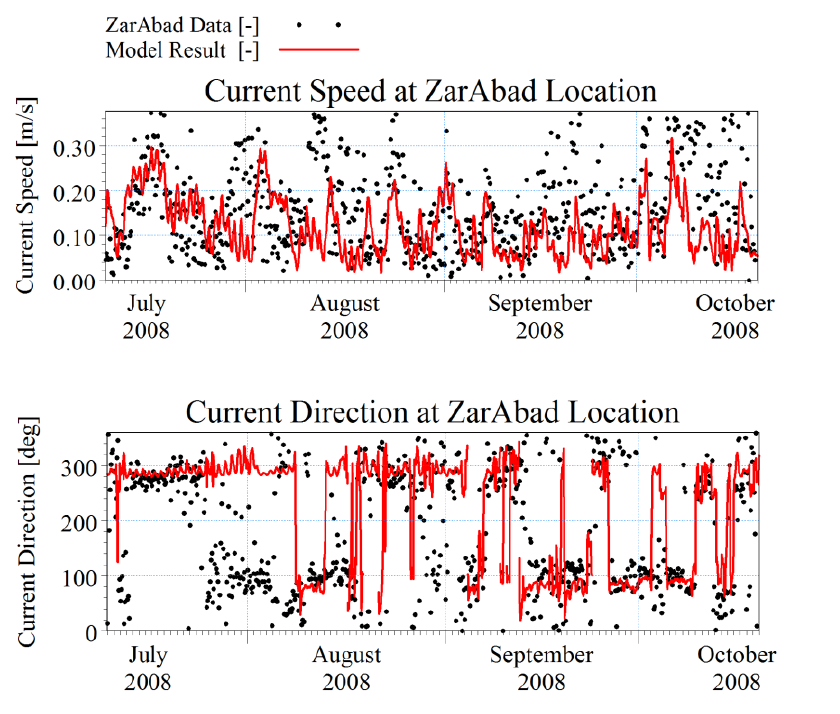
Figure 14. Comparisons between ZarAbad data (black) and model results (red).